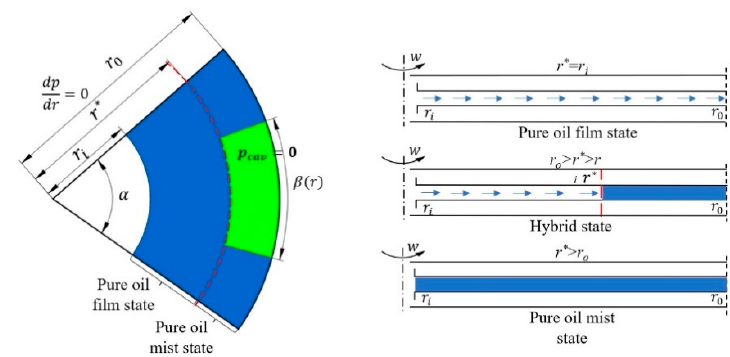
outer diameter of clutch disc, respectively.